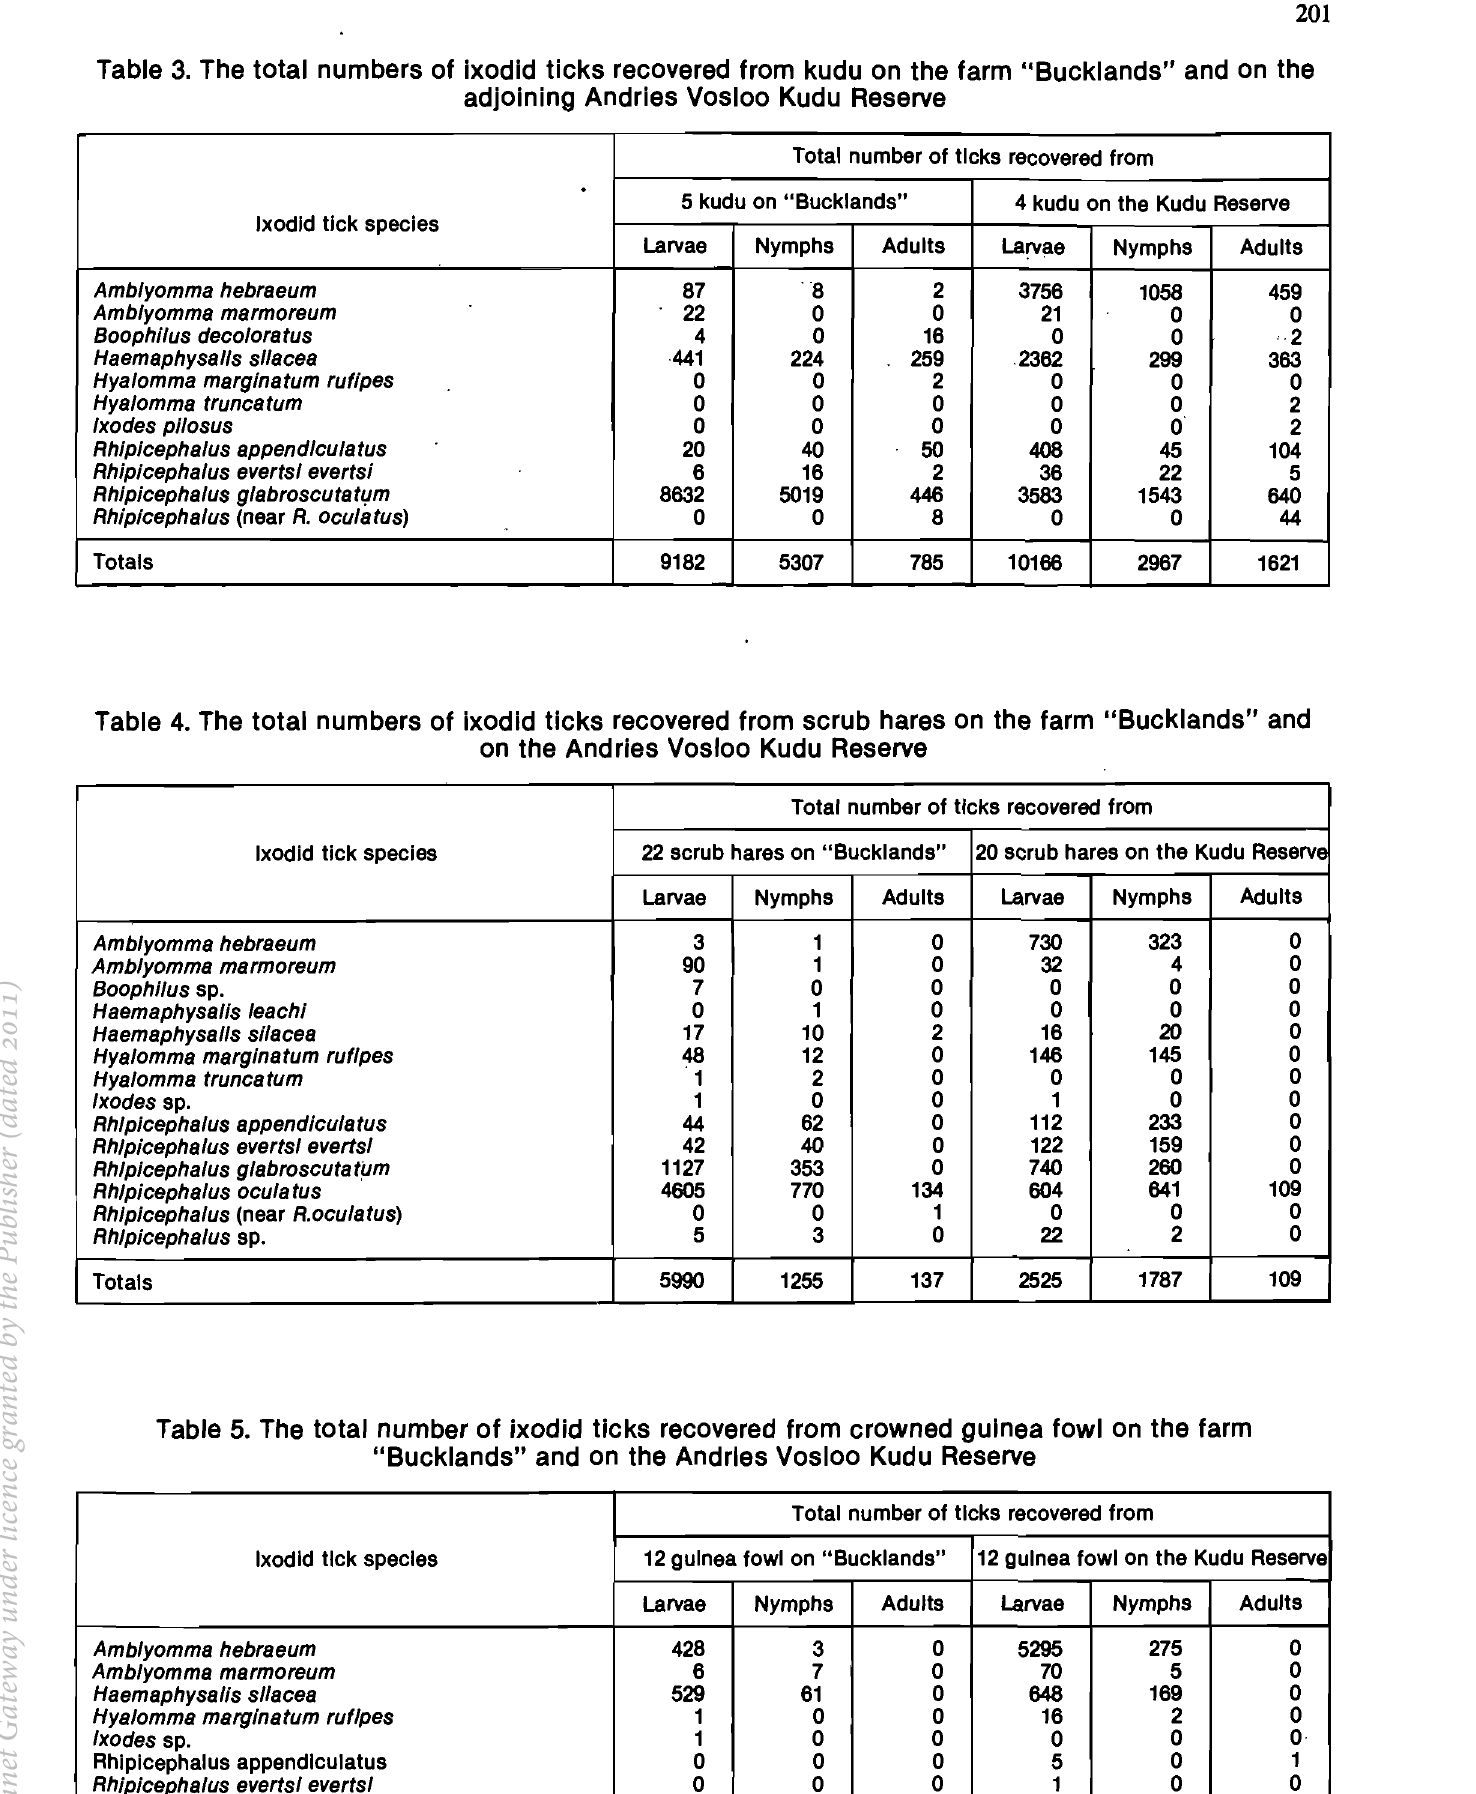
Table 3. The total numbers of ixodid ticks recovered from kudu on the farm "Bucklands" and on the adjoining Andries Vosloo Kudu Reserve Total number of ticks recovered from . 5 kudu on "Bucklands" 4 kudu on the Kudu Reserve Ixodid tick species Larvae Nymphs